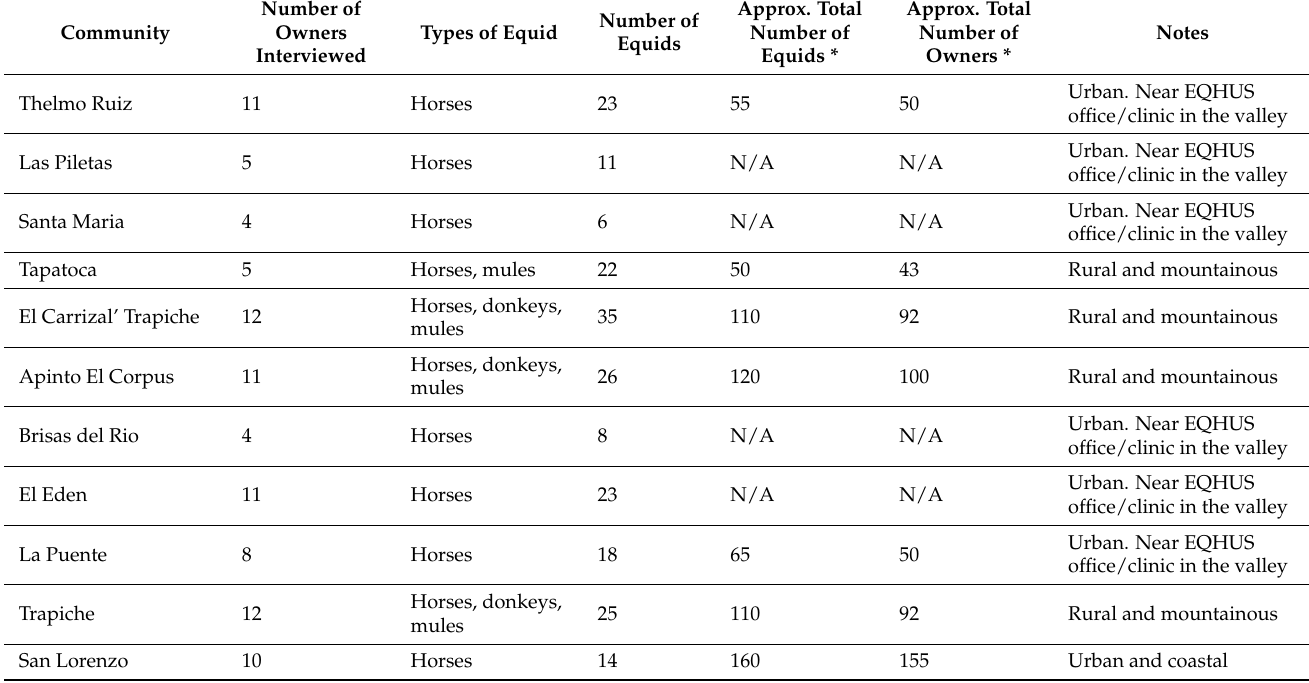
Table 1. Descriptions of communities where the owner questionnaires were carried out. Field notes related to each community are presented in Supplementary Materials (Table S1). * Asterisk denotes data for approximate total number of equids and owners registered to EQHUS in these